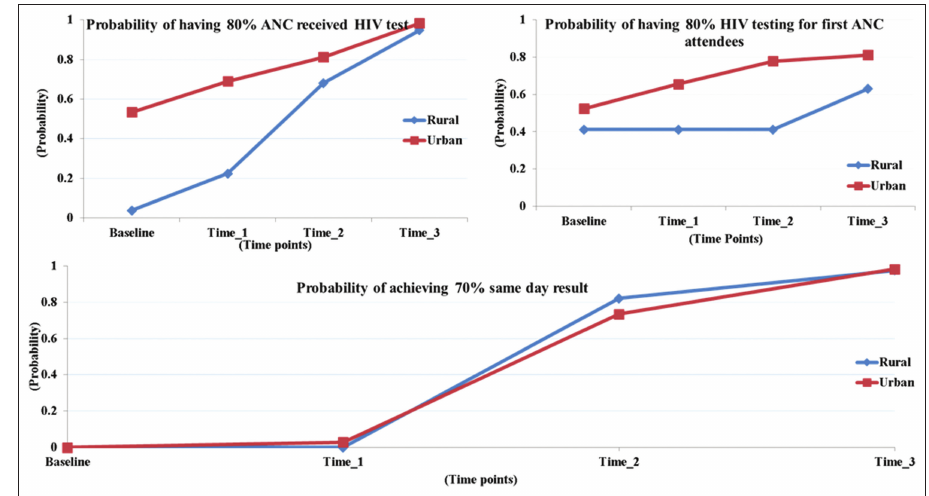
Figure 1: 80% probability for ANC attendees being tested for HIV, 80% for HIV testing coverage at first ANC visit, and 70% for receiving same-day results